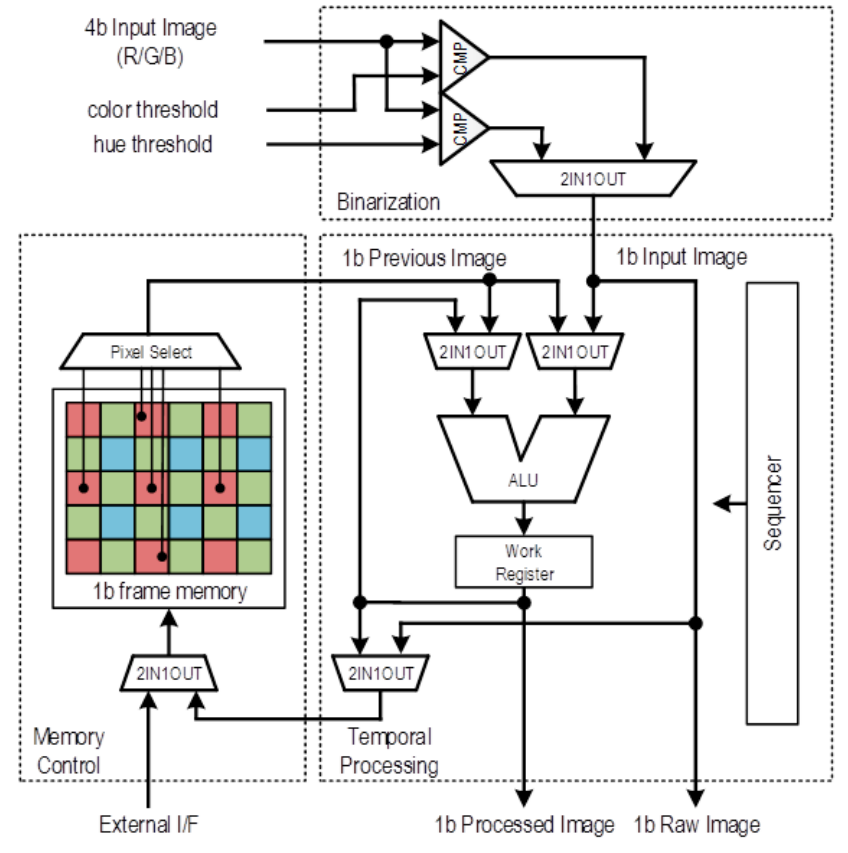
Figure 8. Schematic of the 1b PE with frame memory.